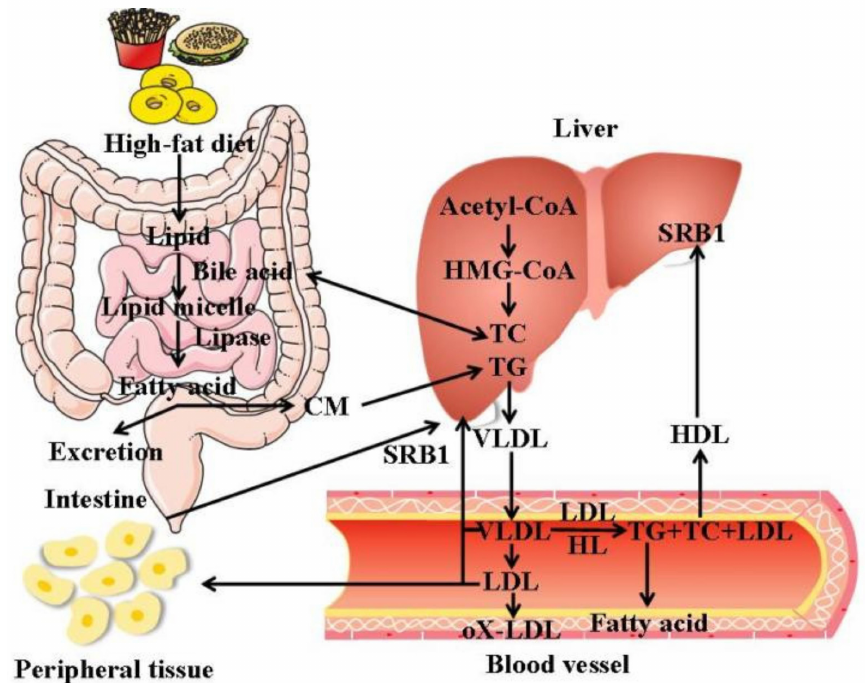
Figure 1. Lipid metabolism in